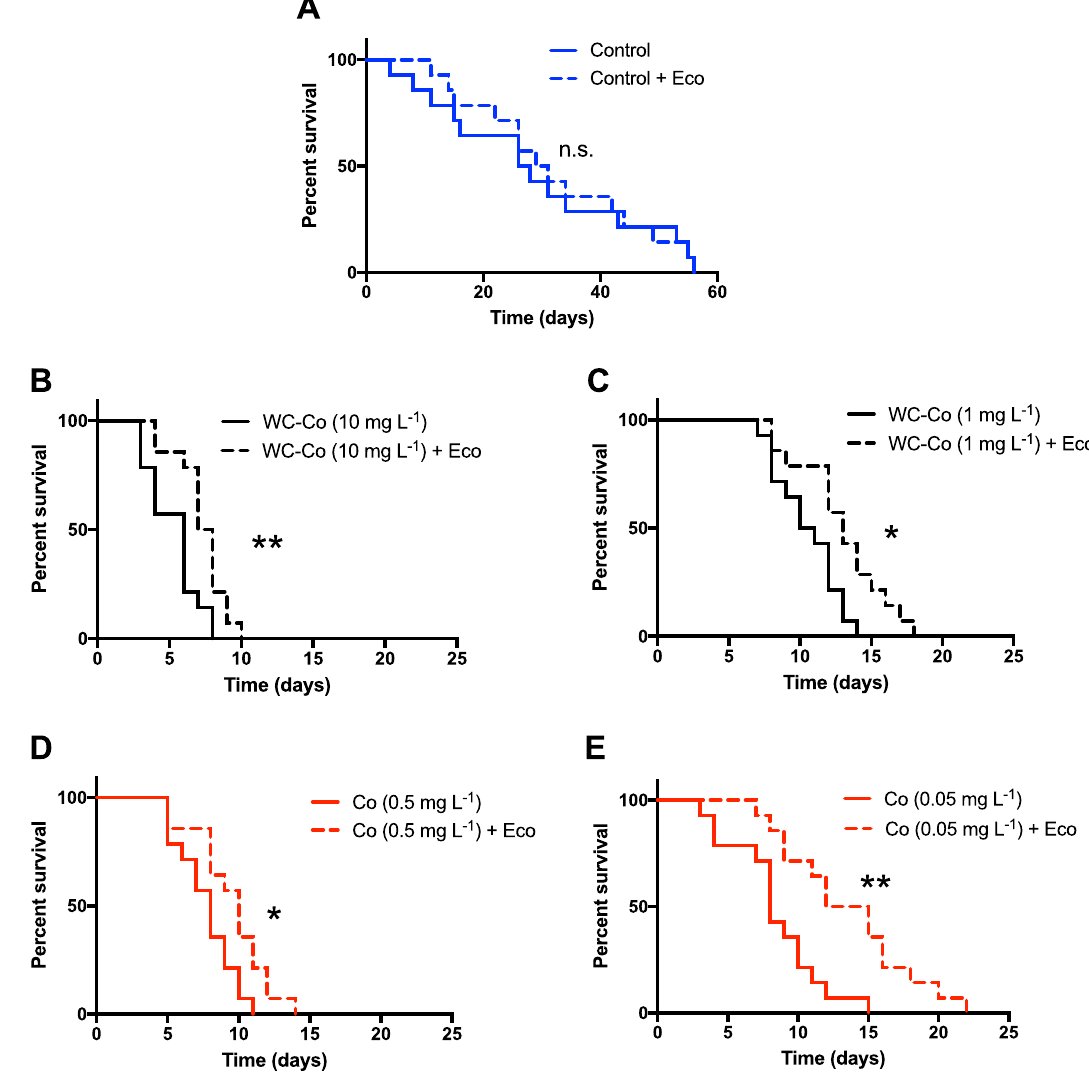
Figure 2. Kaplan–Meier survival curves for Daphnia magna with (solid line) and without (dashed line) addition of eco-corona biomolecules. Data is shown for Control ( A ), WC–Co NPs at concentrations of 10 mg L −1 ( B ) and 1 mg L −1 ( C ), and for Co NPs at concentrations of 0.5 mg L −1 ( D ) and 0.05 mg L −1 ( E ), corresponding to the 5 wt% Co included in WC–Co. Eco denotes excreted eco-corona biomolecules. One asterisk denotes significant differences at the 5% level and two asterisks at the 1% level, whereas n.s. denotes no significant difference. Each treatment was replicated 14